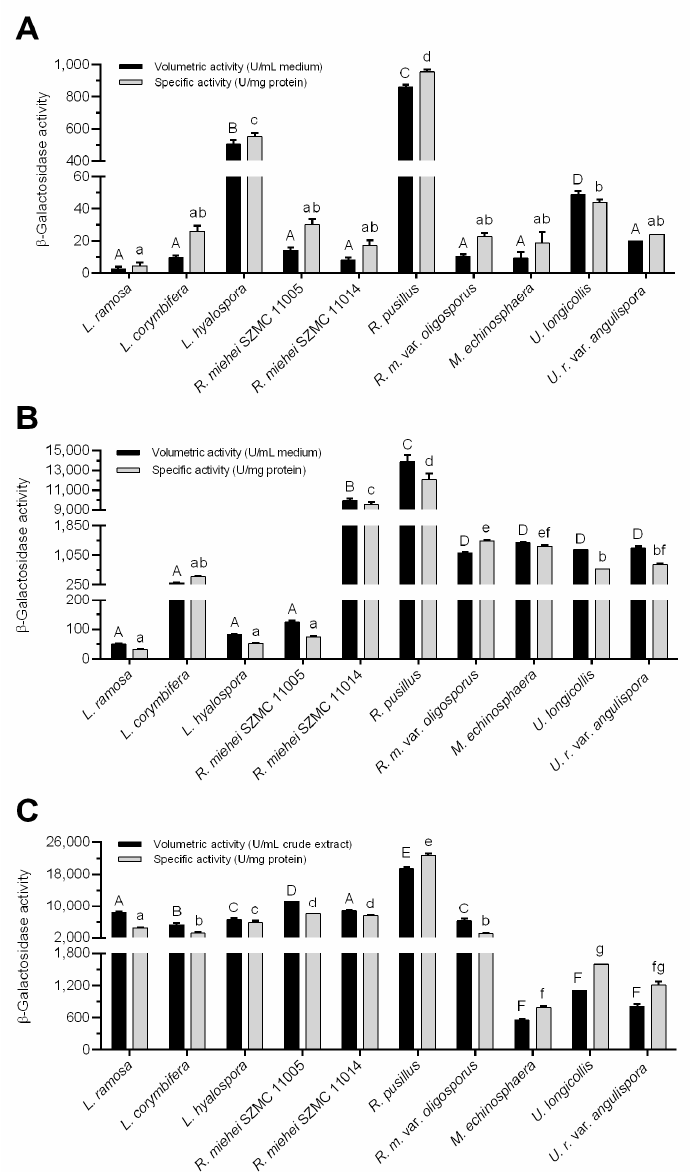
Figure 2. Comparative evaluation of best β -galactosidase yields (volumetric and specific activities) achieved with β -galactosidase-producing Mucoromycota fungi under different fermentation conditions. ( A ) Submerged fermentation (SmF) with medium containing 20 g/L lactose. Presented activities were measured on the 2nd day of incubation by L. ramosa , L. corymbifera , R. miehei , R. microsporus var. oligosporus and U. ramanniana var. angulispora , 4th day by R. pusillus and 7th day by L. hyalospora , M. echinosphaera and U. longicollis . ( B ) SmF with medium containing 20 g/L lactose and wheat bran. Presented activities were recorded on the 7th day except for R. microsporus var. oligosporus (2nd day) and L. corymbifera , L. hyalospora , M. echinosphaera and U. longicollis (4th day). ( C ) Wheat bran-based solid-state fermentation (SSF). Presented activities were determined on the 7th day of fermentation except for M. echinosphaera , U. longicollis and U. ramanniana var. angulispora (4th day). The cultivation temperature was 20 ◦ C for M. echinosphaera , 25 ◦ C for U. longicollis and U. ramanniana var. angulispora , and 37 ◦ C for L. ramosa , L. corymbifera , L. hyalospora , R. miehei , R. pusillus and R. mi- crosporus var. oligosporus . Values are averages computed from three replicates; error bars represent standard deviation. The different uppercase letters (within volumetric activity) or lowercase letters (within specific activity) above the columns indicate significant differences according to one-way ANOVA followed by Tukey’s multiple comparison test ( p <